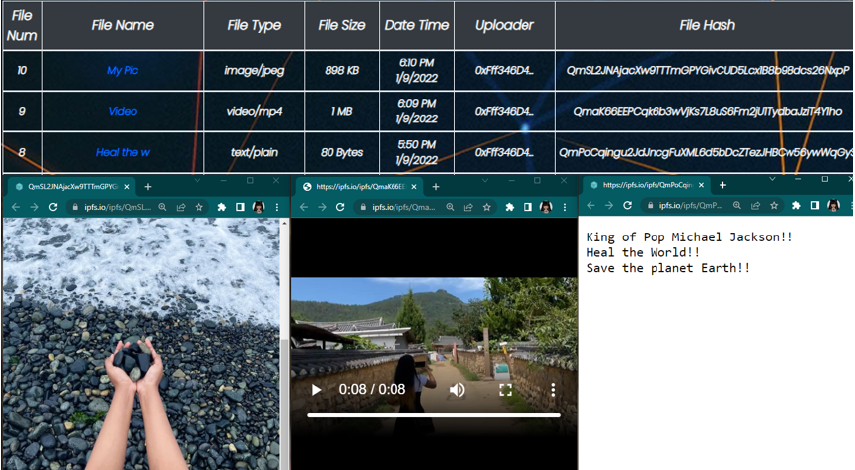
Figure 18. Event log and file